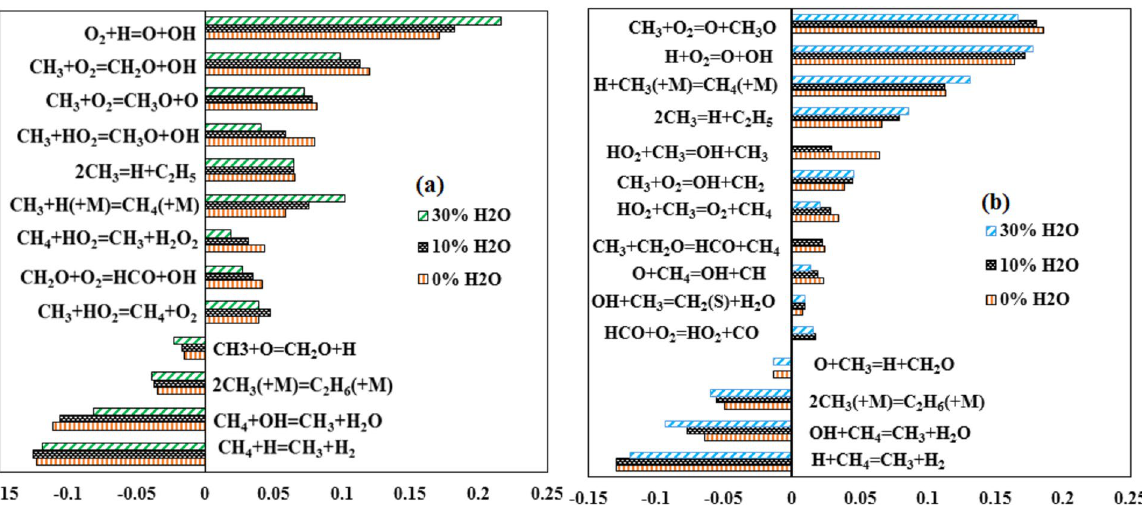
Figure 6. Sensitivity analysis of OH formation rate for different dilution cases using ( a ) Aramco and ( b ) GRI- 3.0 mechanism for stoichiometric mixture at 1.6 atm and 1800